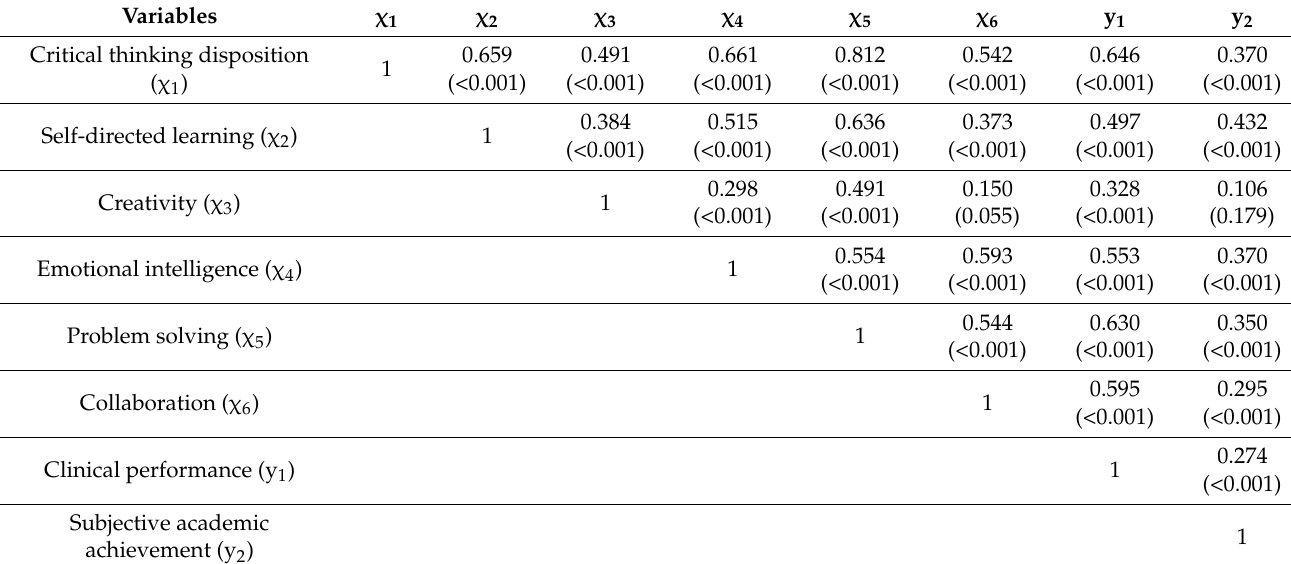
Table 3. Correlation between the sub-dimension of social emotional competencies and academic performance ( n = 195).